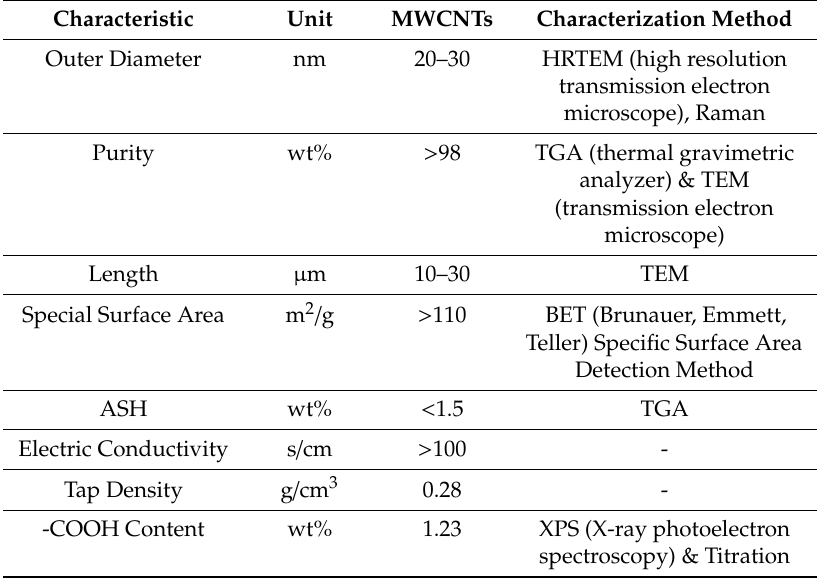
Table 1. Performance parameters of carboxylated multi-walled carbon nanotubes.